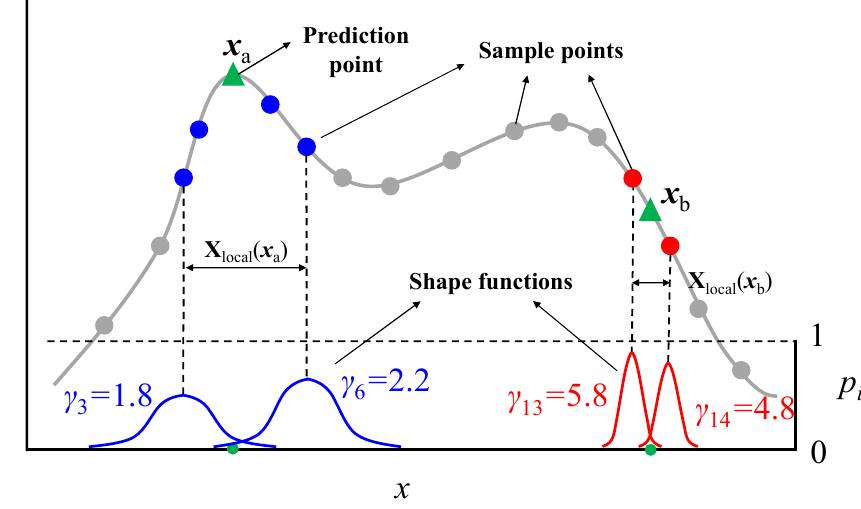
Figure 2. Schematic diagram of the ALMESM basis function in a case with one variable.